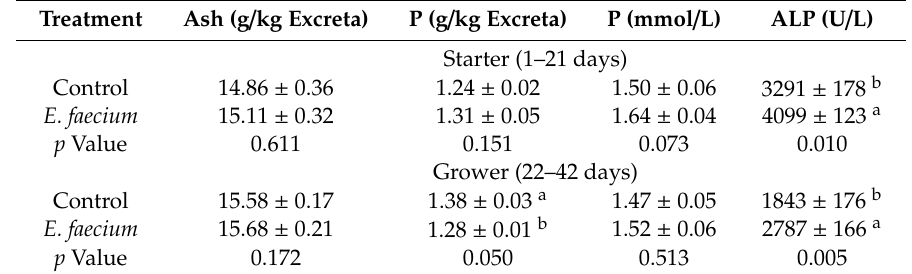
Table 4. Dietary E. faecium supplementation and excreta ash and P content, serum P concentration and alkaline phosphatase (ALP) of